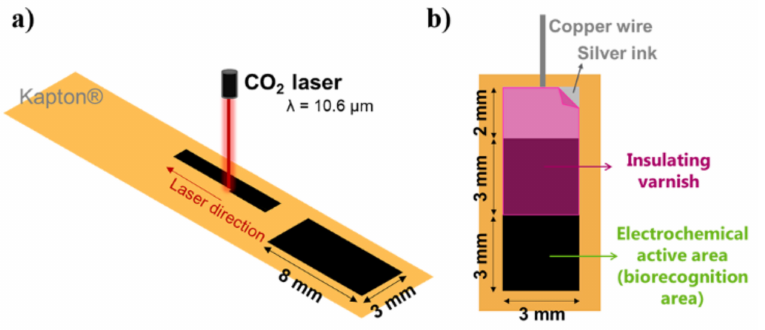
Figure 1. Schematic representation of ( a ) LIG synthesis by the DLS method and ( b ) LIG electrode produced for electrochemical